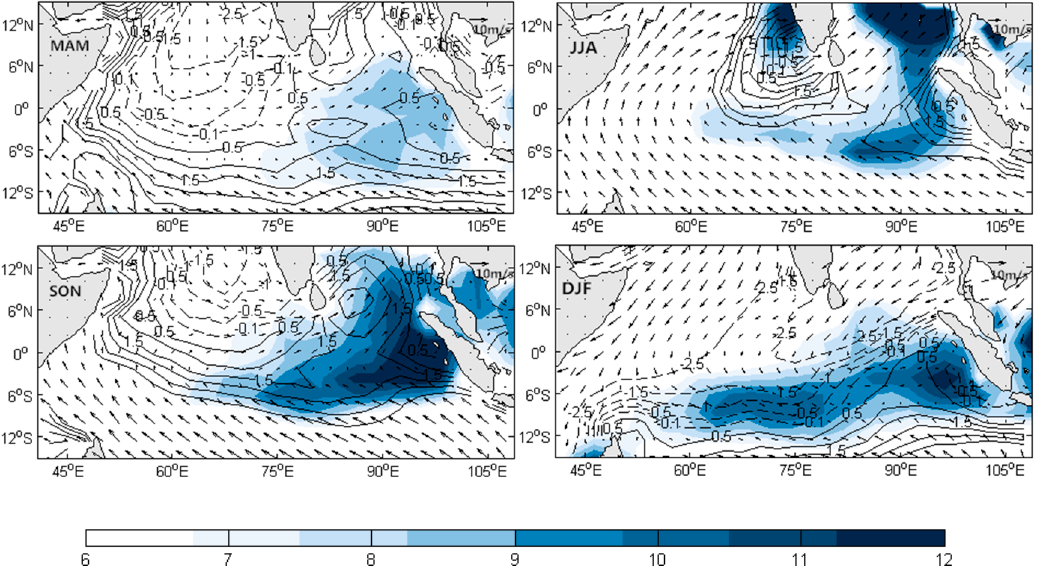
Figure 6. Mean precipitation (shade, mm/day), surface wind velocity (vectors, m/s) and meridional wind (contours, m/s, interval: 0.5 m/s). Solid ones indicate southerlies and dashed ones indicate northerlies.